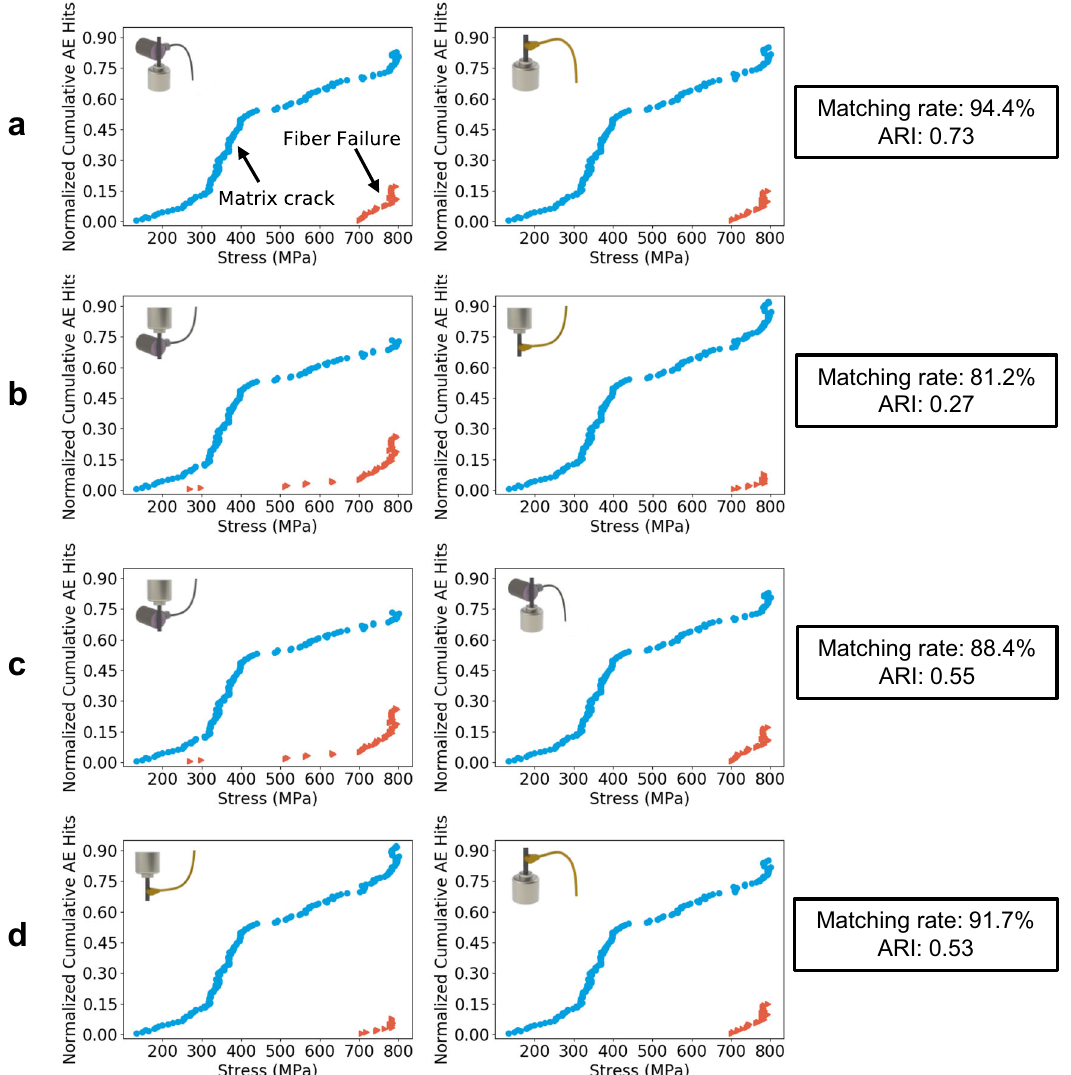
Fig. 3 Damage mechanism identi fi cation from acoustic emission (AE) signals. AE waveforms were generated by SiC/SiC ceramic matrix composites (CMCs) loaded under uniaxial tension and recorded by four sensors: a B1025-b and S9225-b, b B1025-a and S9225-a, and at different locations c B1025-a and B1025-b and d S9225-a and S9225-b. Cluster assignment of individual AE events is consistent across sensors. The resultant identi fi cation of AE events closely follows CMC damage chronology, wherein early matrix cracking is later followed by fi ber breaks, even though the approach is fully domain-knowledge agnostic. The cluster that becomes active at ≈ 85% of the UTS is labeled as fi ber failure, consistent with experiment 11 . Additionally, the partitions were highly precise across both the model and location of the sensors, and the partitioning was